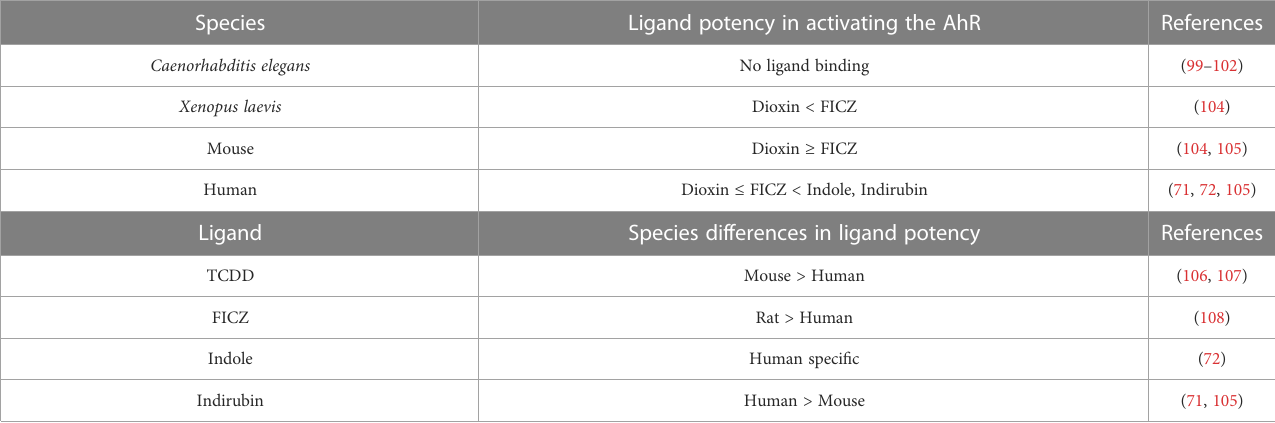
TABLE 2 Species differences in AhR ligand speci fi city and activation of the AhR.